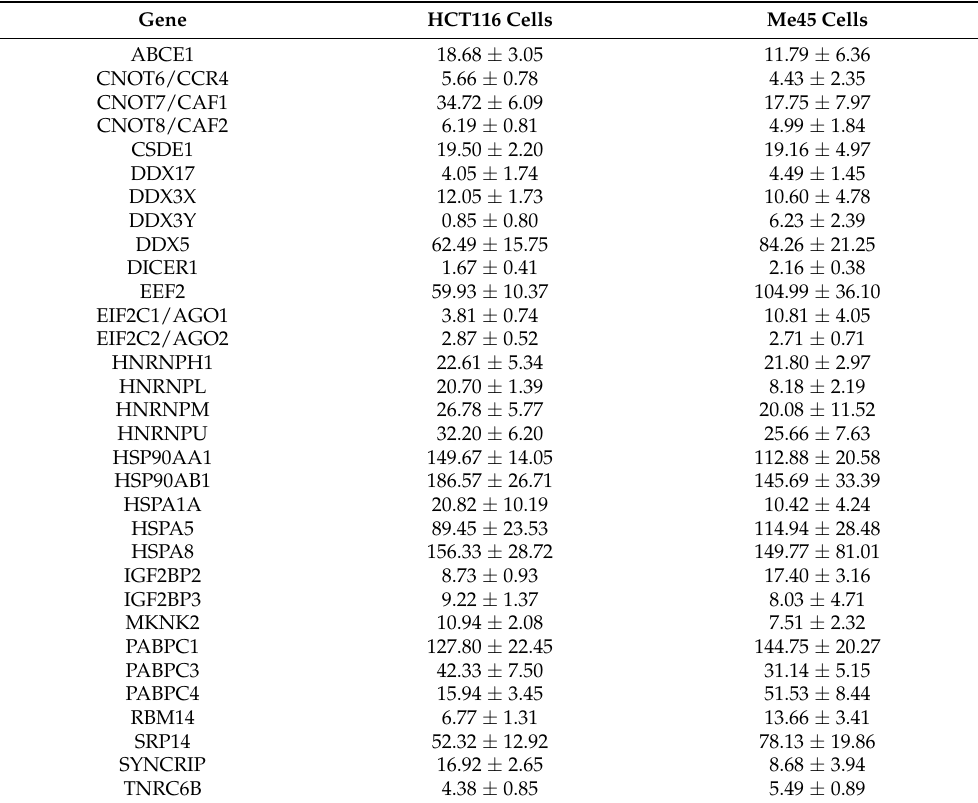
Figure 5. Distribution in sucrose gradients of control and miRNA-targeted Renilla and non-targeted firefly luciferase mRNAs from HCT116 or Me45 cells. ( A , E ): non-targeted Renilla mRNA, ( B , F ): Renilla mRNA targeted by miR-21, ( C , G ): Renilla mRNA targeted by miR-24, ( D , H ): Renilla mRNA targeted by Let-7group miRNAs. * indicate the significance with p -value < 0.05 compared to control transcripts (unregulated). Fractions number 1—free RNA, 2—small subunit, 3—monosome, 4—light polysome, 5—heavy polysome. Table 2. Expression of genes coding for proteins (mRNA levels *) which may be engaged in modula- tion of